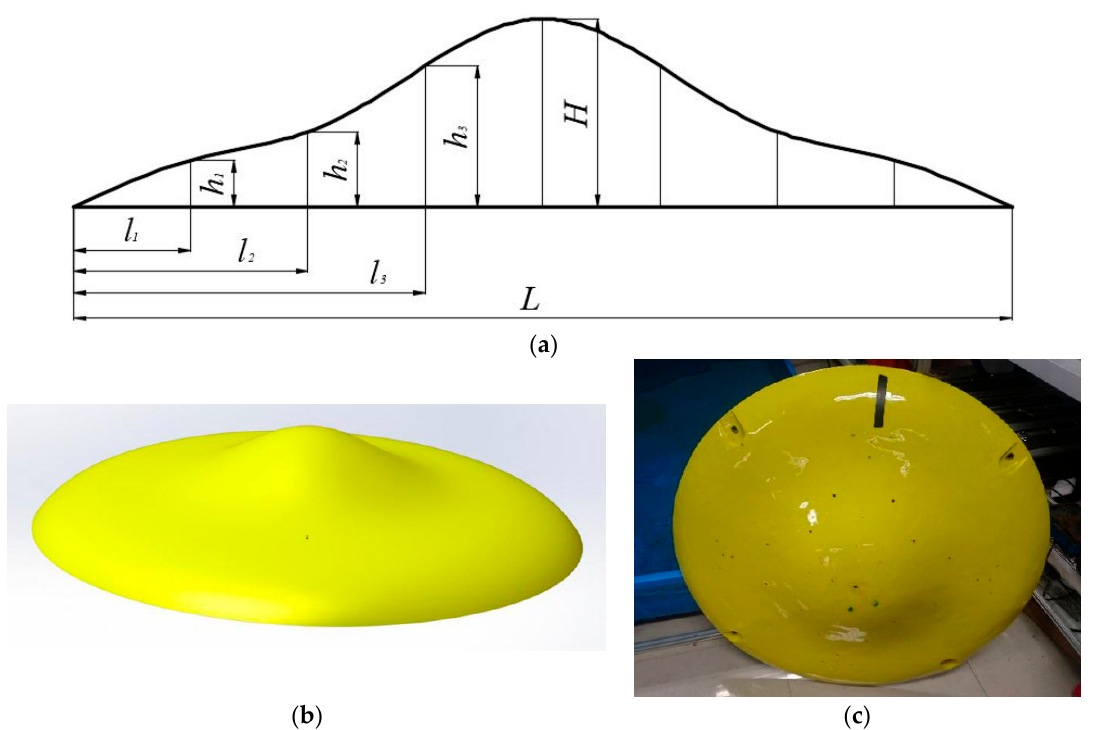
Figure 7. ( a ) Parameters of the disc-shaped hull; ( b ) 3D model of the hull; ( c ) photo of the disc-shaped hull.